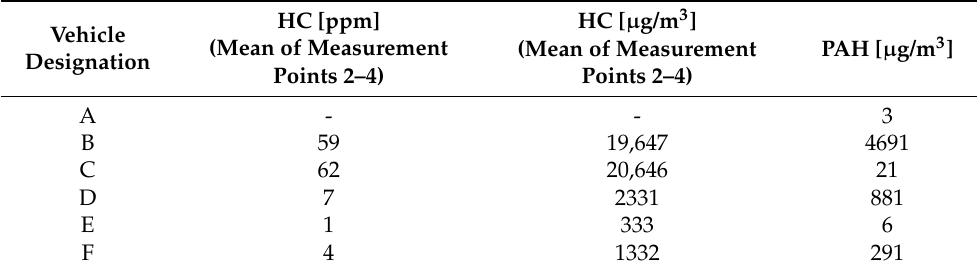
Table 5. The HC and PAH contents in engine exhaust gases.